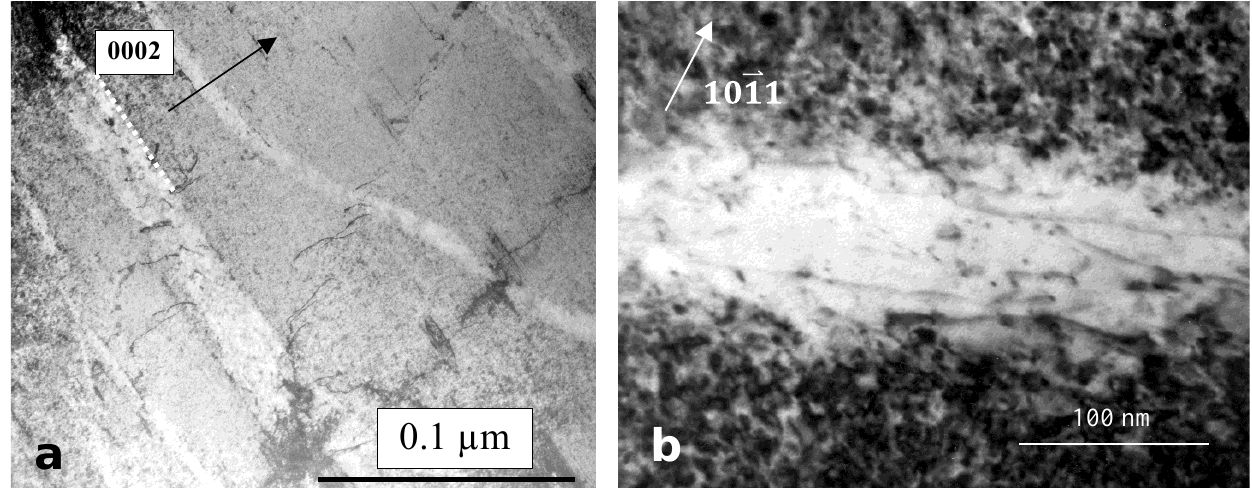
Figure 5. Engineering tensile stress–strain curve for a Zircaloy-2 sheet that had been irradiated at 300 °C to a neutron fluence of 1.1 × 1025 nm −2 and subsequently tested at 25 °C at a strain rate of 4.7 × 10 −6 s −1 . For description of points (a–d), see text. Modified from [17].